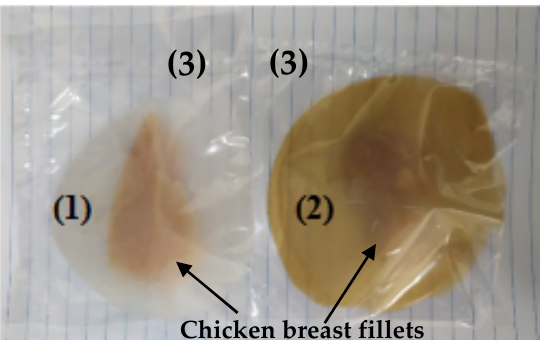
Figure 11. Chicken breast fillets vacuum packaged with (1) “control” LDPE film, (2) LDPE/CS_BO10 film, and (3) package foil.